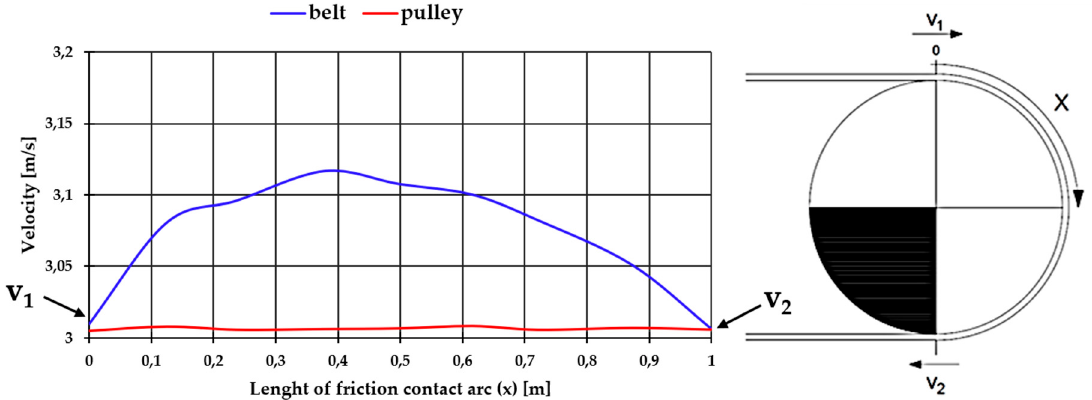
Figure 14. Belt velocity distribution on the length of friction contact arc of the drive pulley and pulley surface velocity for one case (average linear belt velocity 3.07 m/s, belt pre-tension 33 kN, torque on the pulley shaft 400 Nm, belt surface temperature 292.65 K).